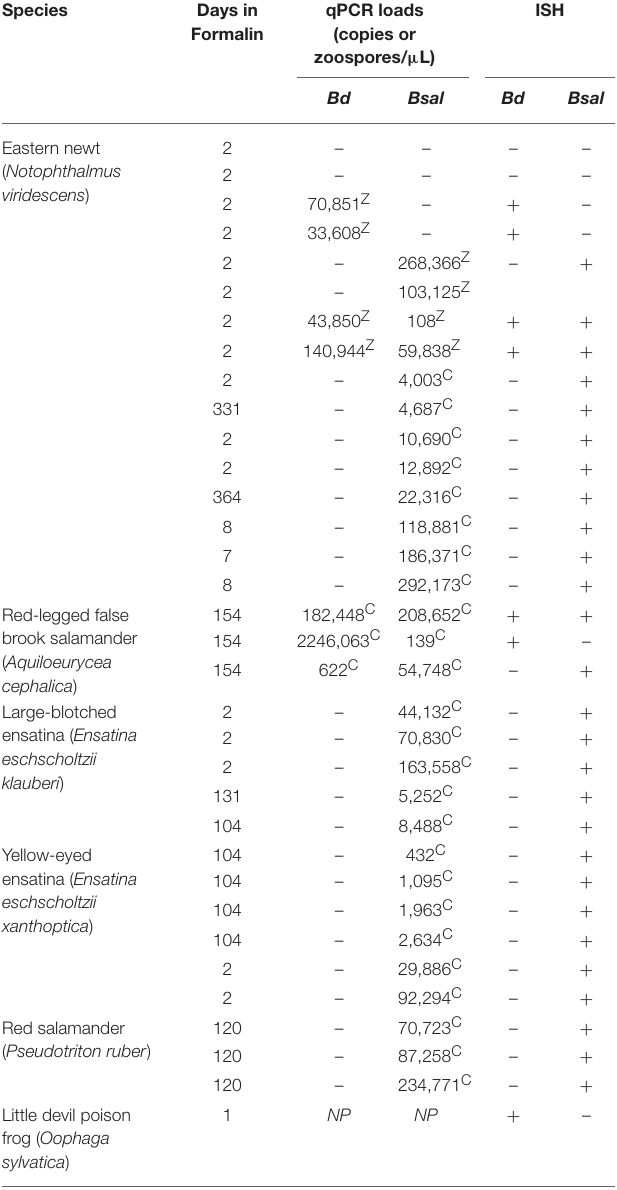
TABLE 1 | Summary of animals used for Bd / Bsal RNAScope ® ISH validation.